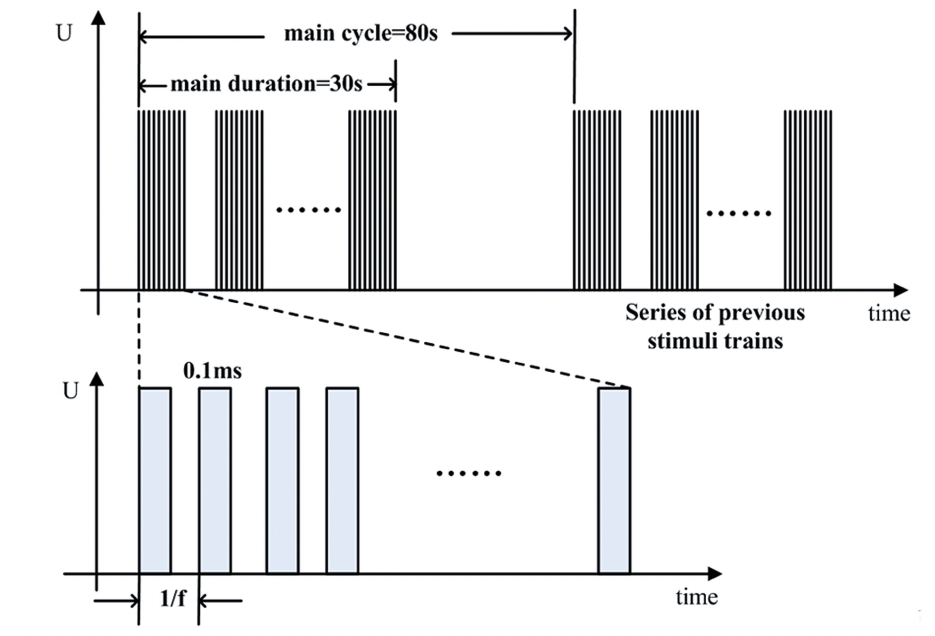
figure 2 - The stimuli used in the experiments. The pulses were monophasic negative pulses with frequency of 20 hz, pulse duration of 0.1ms, train duration of 30 sec, and train period of 80 sec. The stimulation amplitude was about 1.5-4.0 v, which is variable for individual